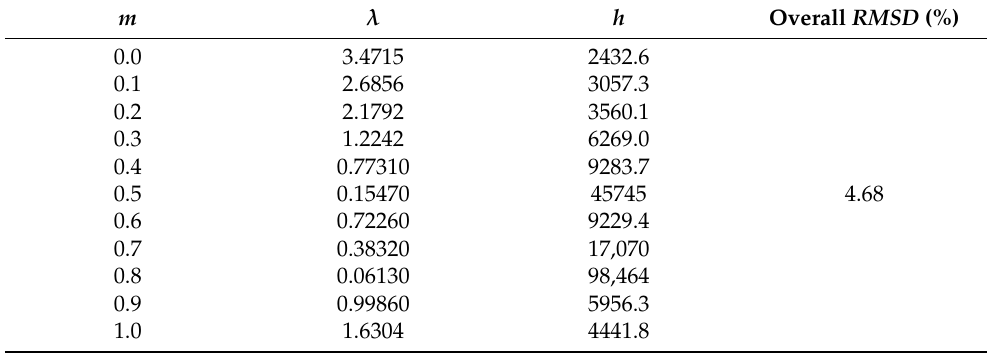
Table 7 documents the outcomes of “Buchowski–Ksiazaczak λ h ” results for FXT in cosolvent mixtures and neat solvents. This model’s overall RMSD was computed to be 4.68%. These outcomes also showed a good correlation of FXT’s measured solubility data with “Buchowski–Ksiazaczak λ h model”. Table 7. Buchowski–Ksiazaczak λ h model results for FXT (3) in different {PEG 400 (1) + H 2 O (2)} mixtures.